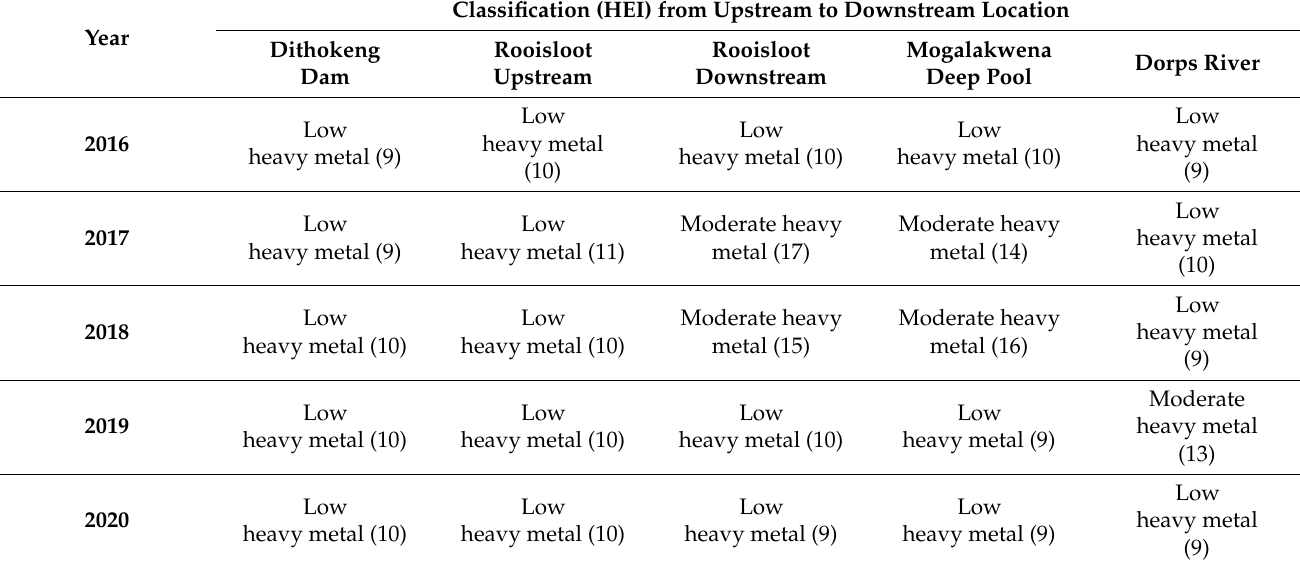
Table 6. Heavy metal evaluation index (HEI) calculation.